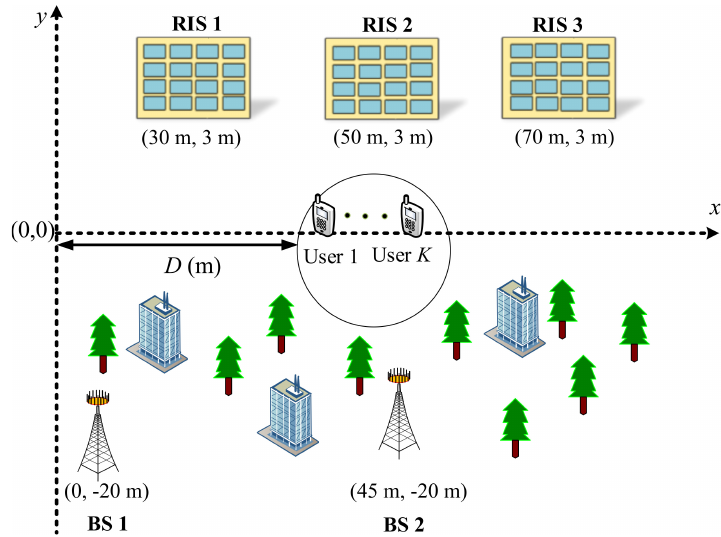
Figure 2. A 2D modeling of the cooperative RIS-aided communication framework.